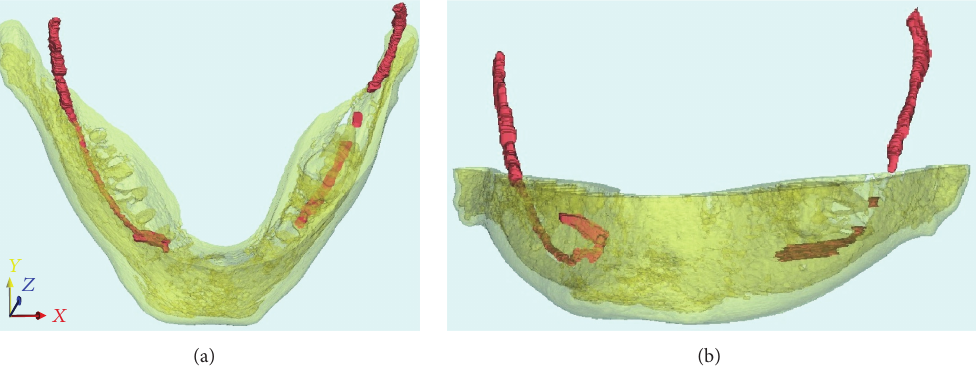
Figure 5: Segmentation of the mandibular canal by using CBCT images with Mimics software.